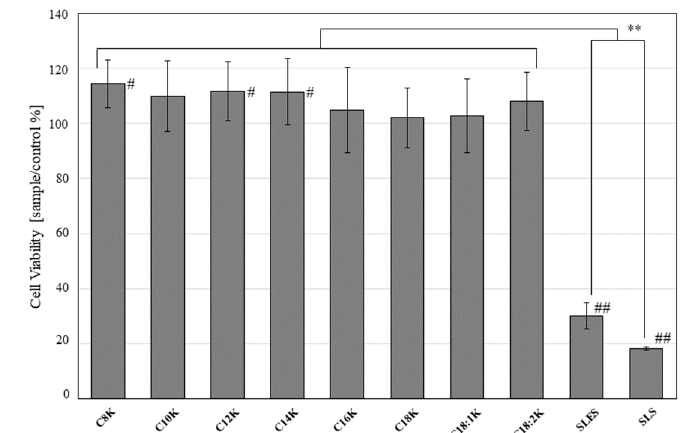
Figure 4. Viability of BALB/3T3 cells that were cultured in Dulbecco’s modified Eagle’s medium (DMEM) for 24 h after they had been treated with 0.5 mM fatty acid potassium, SLES, or SLS for 5 min. Untreated cells were used as the control. Percentage cell viability was calculated relative to the control value. Results are expressed as mean ± SD values ( n = 8). ** p < 0.01, # p < 0.05 and ## p < 0.01 compared to the control.